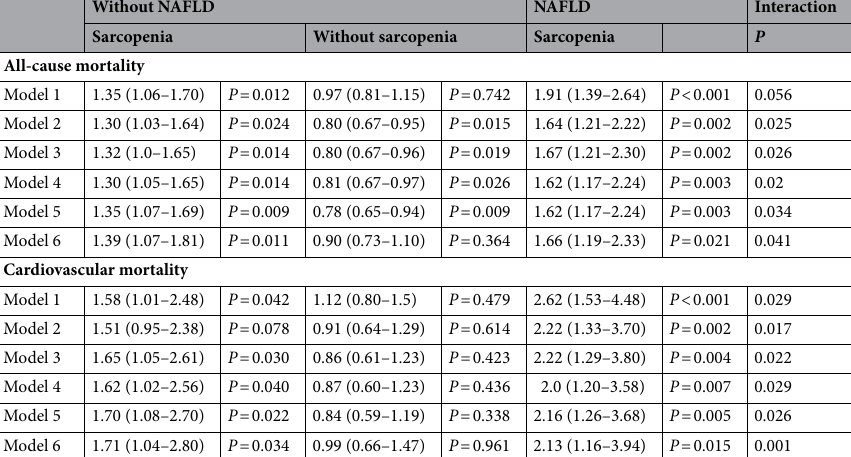
Table 3. All-cause and cardiovascular mortality during 16.8 years of follow-up according to combinations of nonalcoholic fatty liver disease (NAFLD) and sarcopenia status. Subjects without sarcopenia or NAFLD were served as the reference group. Data were presented as hazard ratios (with 95% confidence intervals). Model 1 was adjusted for age, gender, race-ethnicity, and education level. Model 2 was adjusted for smoking and drinking status, body mass index, hypertension, and diabetes in addition to the factors included in model 1. Model 3 was adjusted for total cholesterol, triglyceride, and HDL-cholesterol in addition to the factors included in model 2. Model 4 was adjusted for C-reactive protein in addition to the factors included in model 3. Model 5 was adjusted for HOMA-IR in addition to the factors included in model 3. Model 6 was adjusted for age, gender, race-ethnicity, education level, smoking and drinking status, body mass index, total cholesterol, triglyceride, HDL-cholesterol, nutritional status, number of medications, and number of